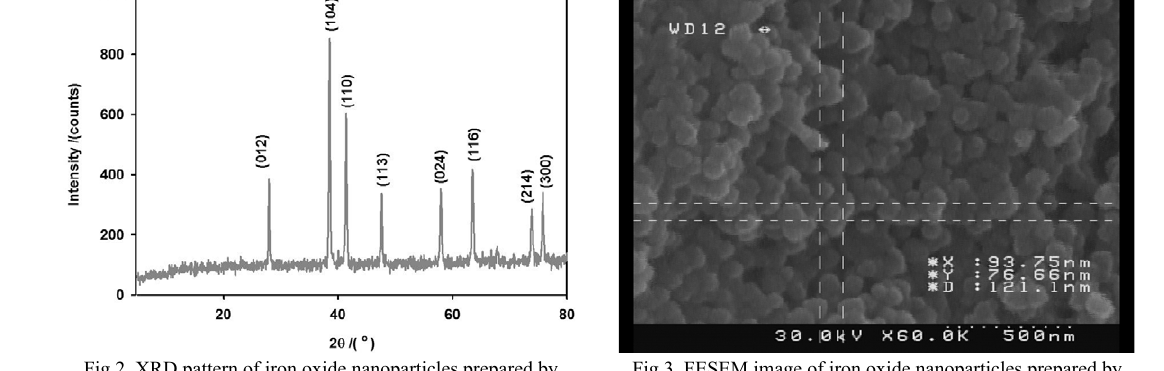
Fig.2. XRD pattern of iron oxide nanoparticles prepared by sol-gel auto-combustion with ultrasonic irradiation.